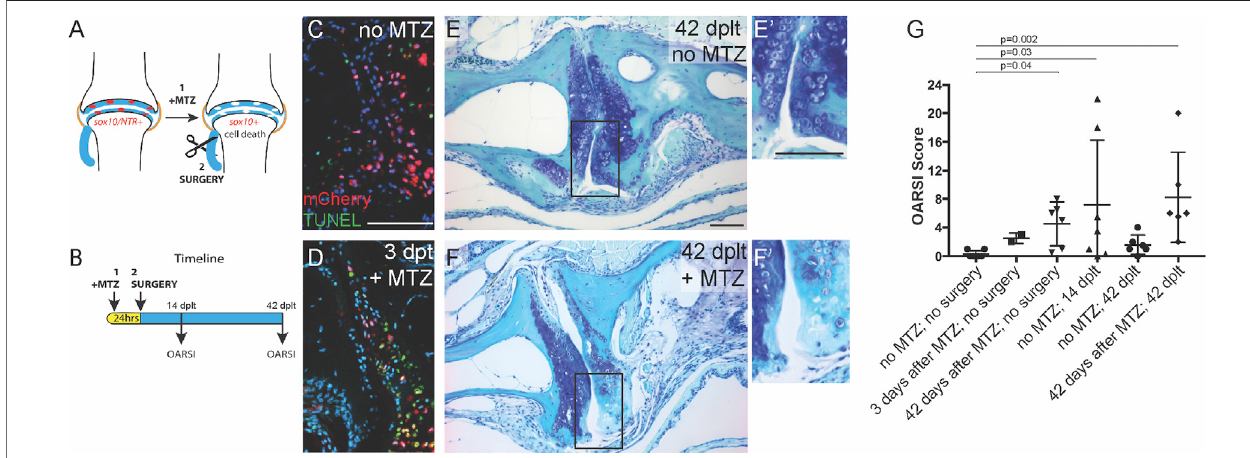
FIGURE3| Sox10-expressingcells arerequired forcartilageregeneration. (A) Genetic ablation model. (B) Timeline fortreatmentand analysis. (C,D) Antibodyand TUNEL staining of the adult jaw joint shows mCherry expression in sox10:mCh-NTR adult joint cells and apoptotic cells in metronidazole (Mtz)-treated animals at (D) 3 days after Mtz treatment (days post-ligament transection, dplt). (E,F) Toluidine blue staining of joints at 42 dplt without (E) or with Mtz treatment (F) prior to ligament injury (insets in E 9 and F 9 show the details ofthe articular surface). (G) OARSI scoring of joint integrity following Mtz treatment and/or ligament injury. Individual data points, mean, and standard error of the mean are shown. The p -values are calculated by Kruskal – Wallis ANOVA and Dunn ’ s multiple-comparison test. Scale bars (cid:1) 50 μ m.